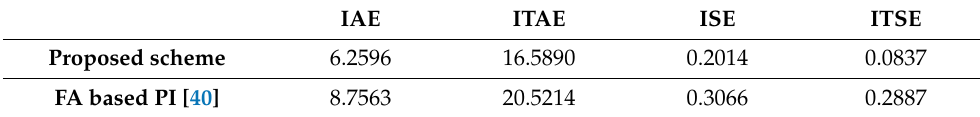
Table 4. Performance indices under disturbance in thermal demand.